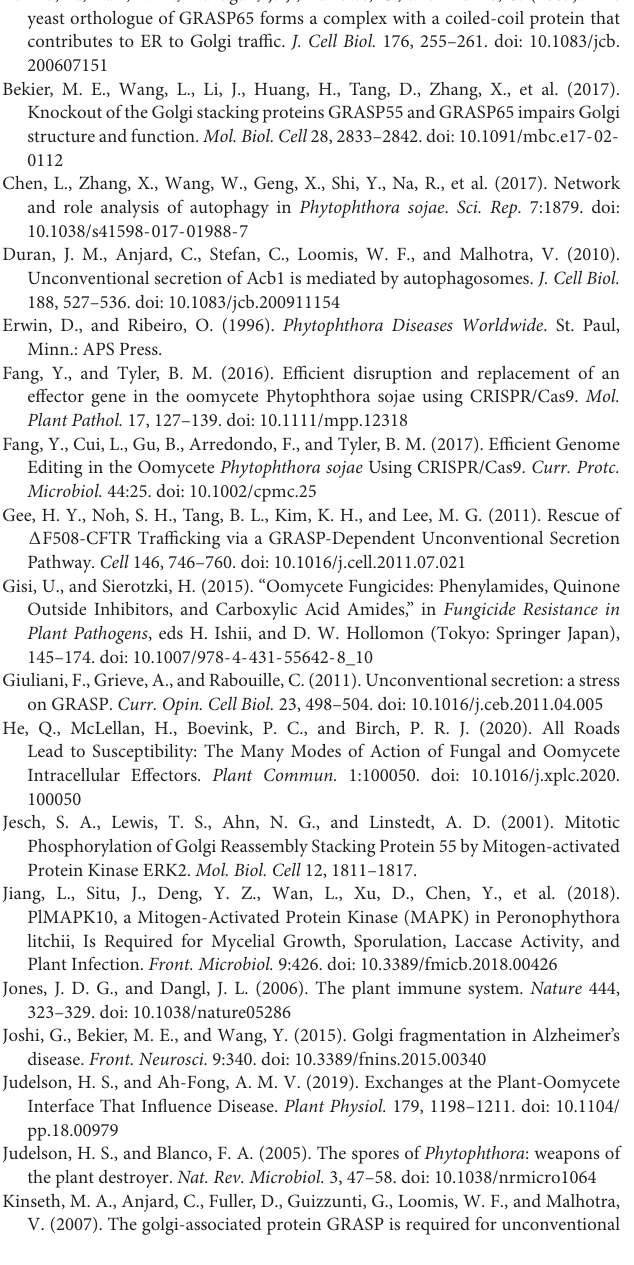
expressed proteins (DEPs) between P6497 and T12. Proteins were predicted the signal peptide (SP). (C) Gene Ontology functional classification of the down-regulation expressed proteins.